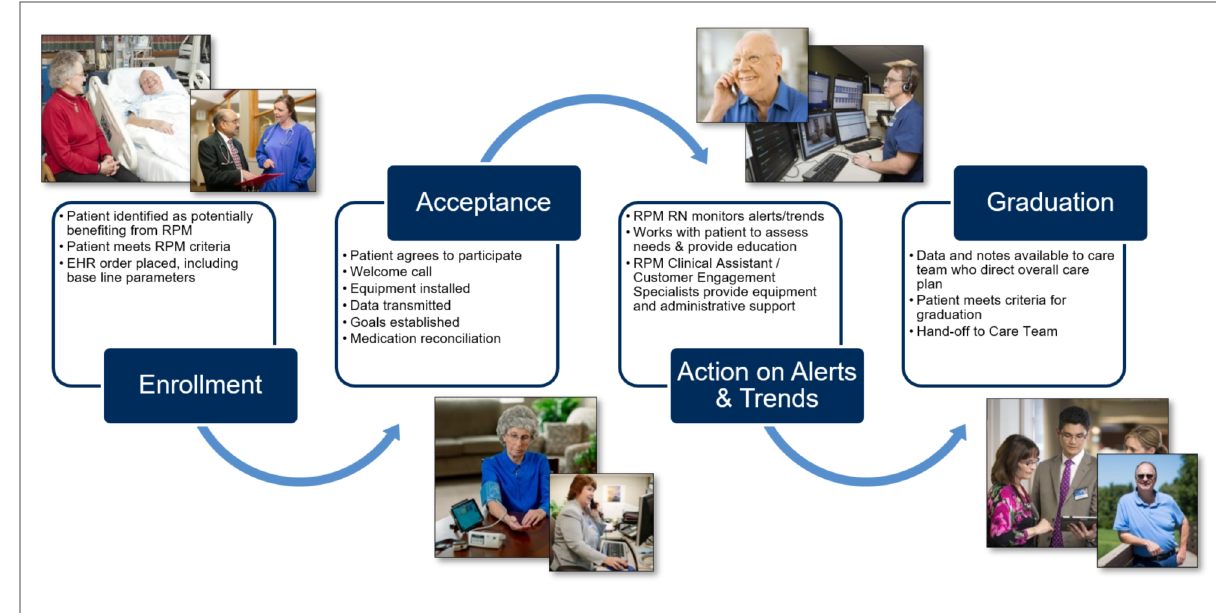
FIGURE 2 High-level patient fl ow through the remote patient monitoring